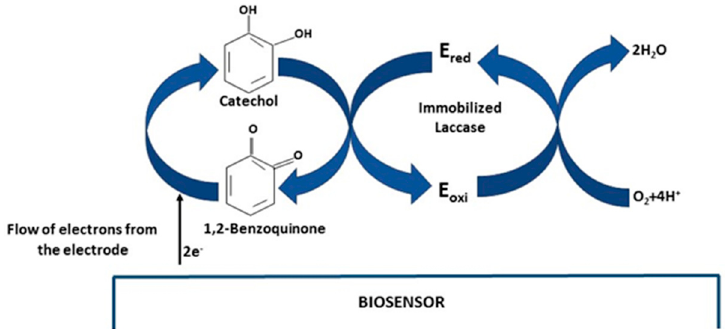
Figure 5. Electron transfer mechanism of catechol oxidation on a laccase biosensor. E red = reduced enzyme and E oxi = oxidized enzyme.